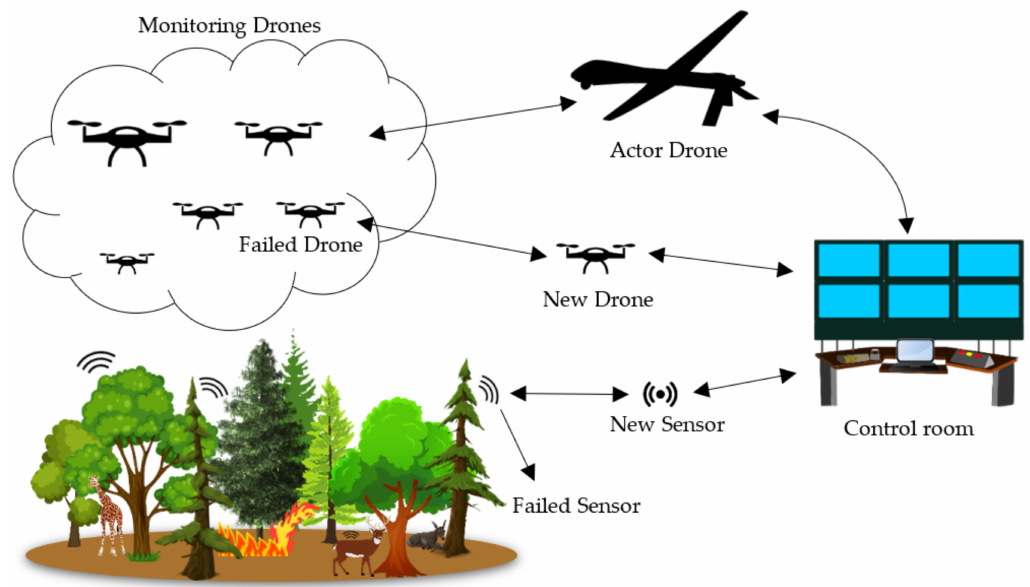
Figure 1. System